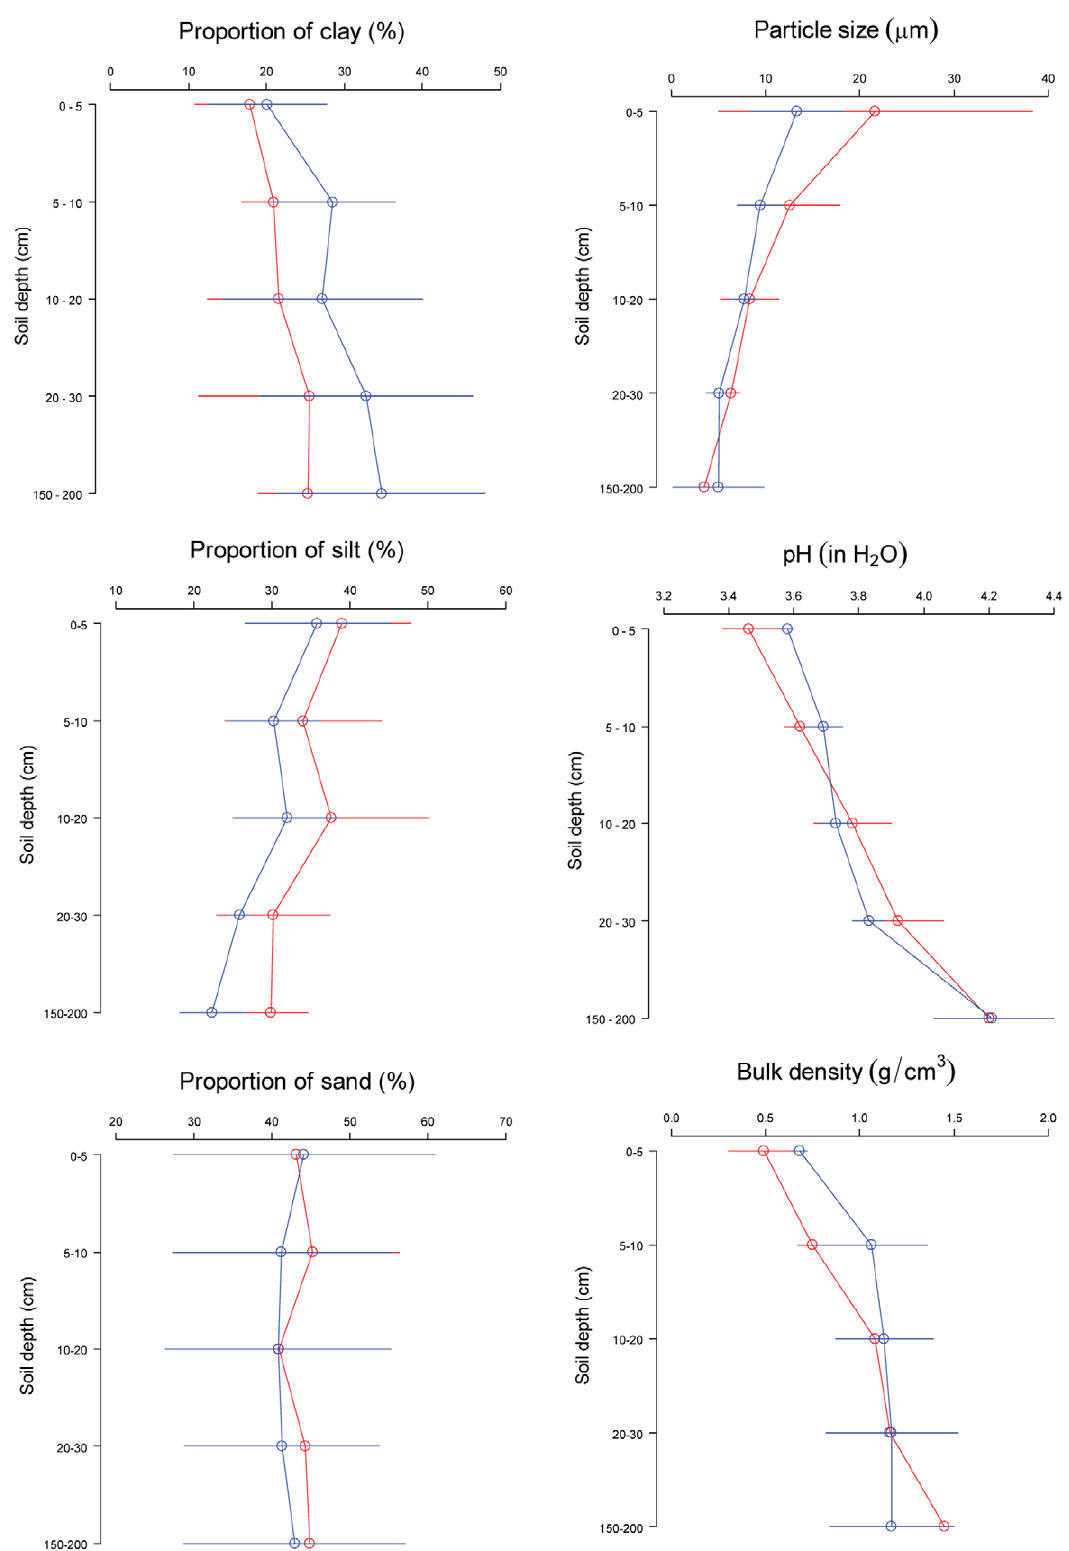
Figure 2. Comparison of the proportion of clay (top left); proportion of silt (middle left); proportion of sand (bottom left); particle size (top right); pH in H 2 O (middle right); and bulk density (bottom right) found in soils at different depths sampled beneath stands of forest dominated the species Gilbertiodendron (red line) and adjacent higher-diversity forests where no species dominates (blue lines). Circles show mean values and error bars indicate 95% confidence intervals (n=3).